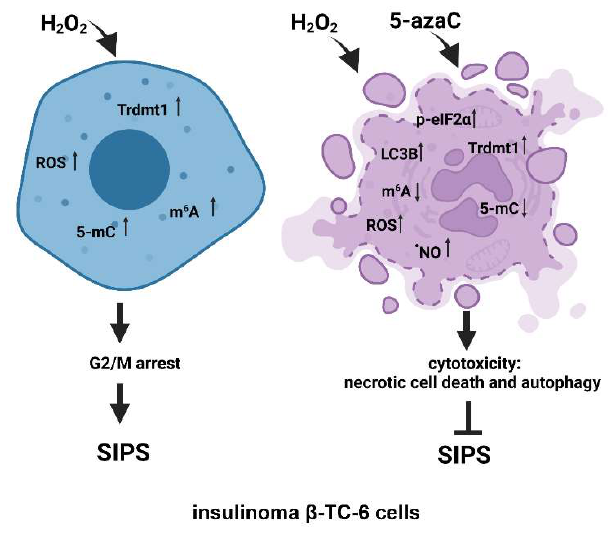
Figure 7. The effects of a methyltransferase inhibitor 5-azaC in hydrogen peroxide-treated mouse insulinoma cells. HP stimulation served as a model of oxidative stress and stress-induced premature senescence (SIPS) ( left ). HP (H 2 O 2 ) treatment resulted in increased levels of Trdmt1, ROS, RNA methylation (5-mC and m 6 A pools), cell cycle arrest at the G2/M phase and increased senescence- associated β -galactosidase (SA- β -gal) activity ( left ). 5-AzaC post-treatment prevented the devel- opment of senescence phenotype in both insulinoma cell lines. In HP-treated β -TC-6 cells, 5-azaC post-treatment promoted nitric oxide-mediated necrotic cell death and cytotoxic autophagy that was accompanied by increased levels of p-eIF2 α and LC3B and diminished levels of RNA methylation parameters ( right ). The levels of Trdmt1 were elevated after 5-azaC post-treatment, but Trdmt1 cannot take part in an adaptive stress response as a result of the inhibitory action of 5-azaC. Thus, this approach can sensitize oxidant-stressed insulinoma cells to 5-azaC treatment resulting in cell